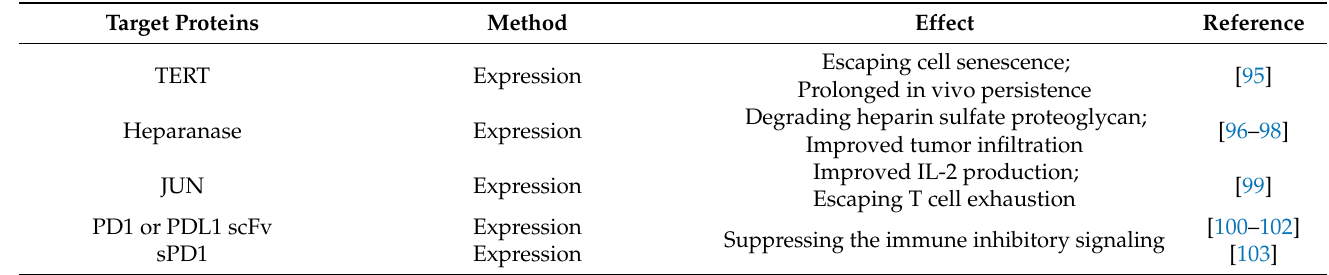
Table 1. Proteins co-expressed or depleted in CAR T